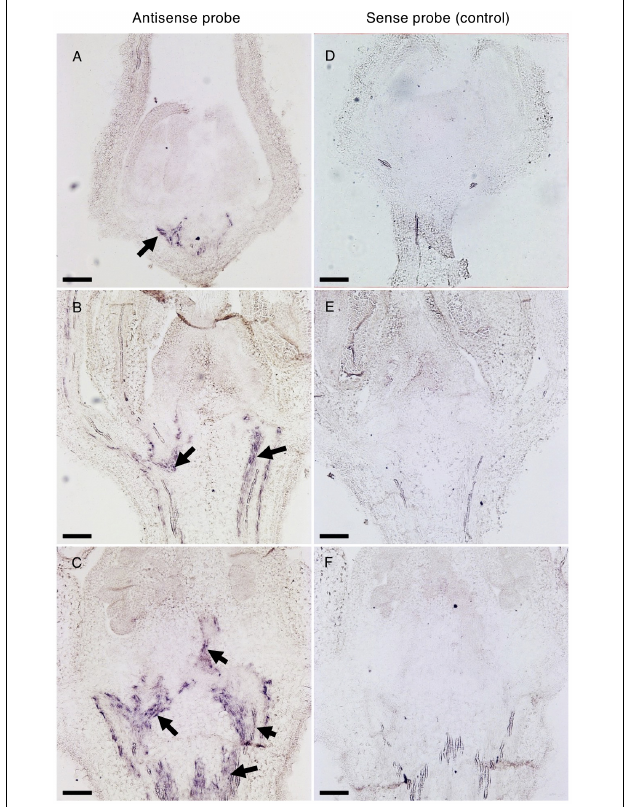
FIGURE 8 | In situ hybridization of Solyc04g077010 transcripts in developing buds. Distribution of Solyc04g077010 expression was detected by an antisense probe (A–C) and a low background signal was detected by a control sense probe (D–F) in 1.1 mm (A,D) , 2.9 mm (B,E) , and 4.5 mm (C,F) buds. Black arrows indicate signals detected in vasculature bundles and their distribution in the receptacle, pedicel, and/or columella. Bars are 100 µ